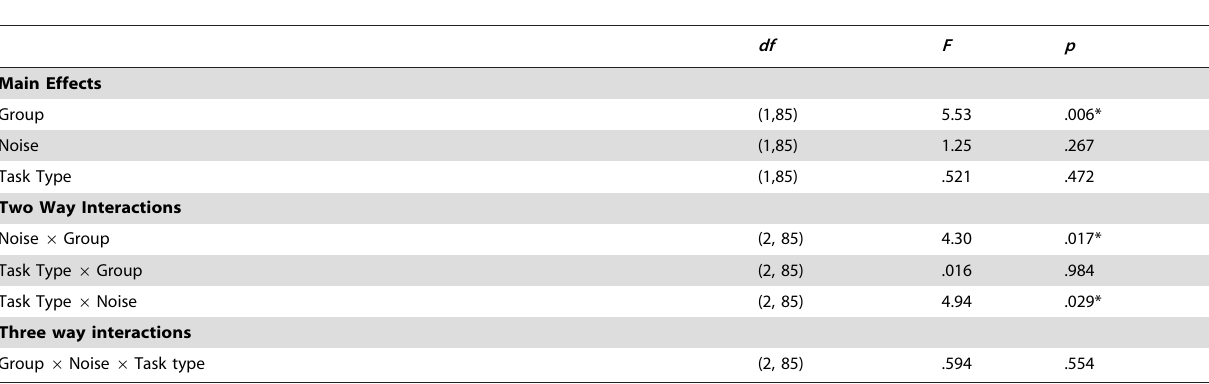
Table 2. Main effects and interactions from a Group X Noise X Task Type repeated measures